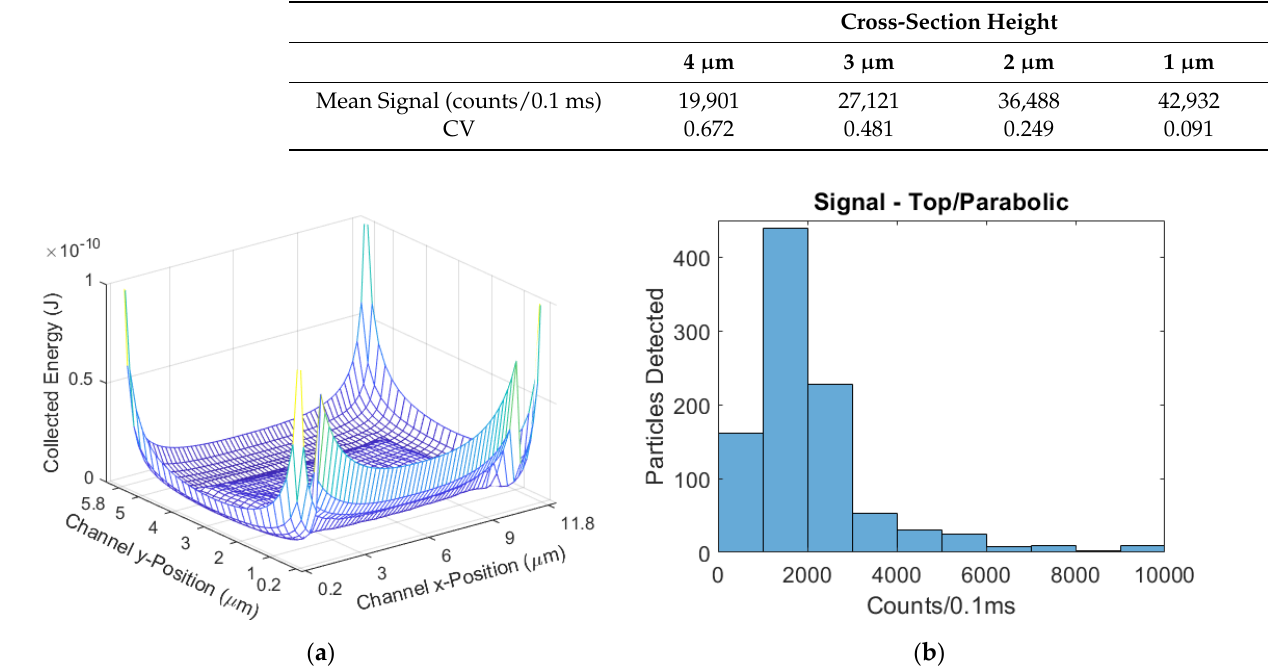
Figure 12. ( a ) The modeled excitation region for the top-illuminated biosensor with a parabolic flow regime; ( b ) The simulated signal distribution.